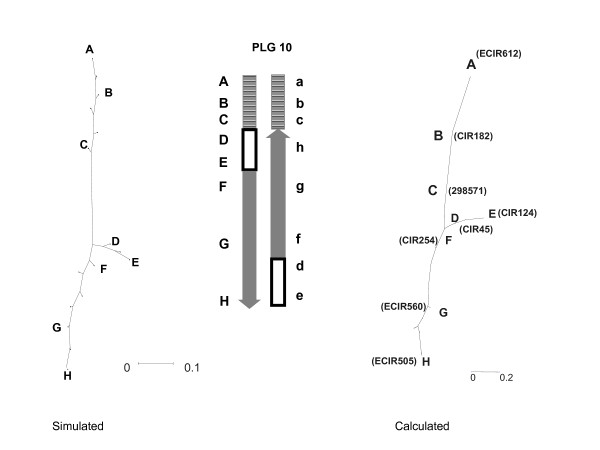
Putative rearrangement event on PLG 10. The figure presents the Neighbor-joining tree designed from Kosambi distance calculation, the putative scheme of the rearrangement, and the simulated Neighbor-joining tree obtained with this kind of rearrangement. In SSR names, mMaCIR has been abbreviated to CIR, mMECIR to ECIR.